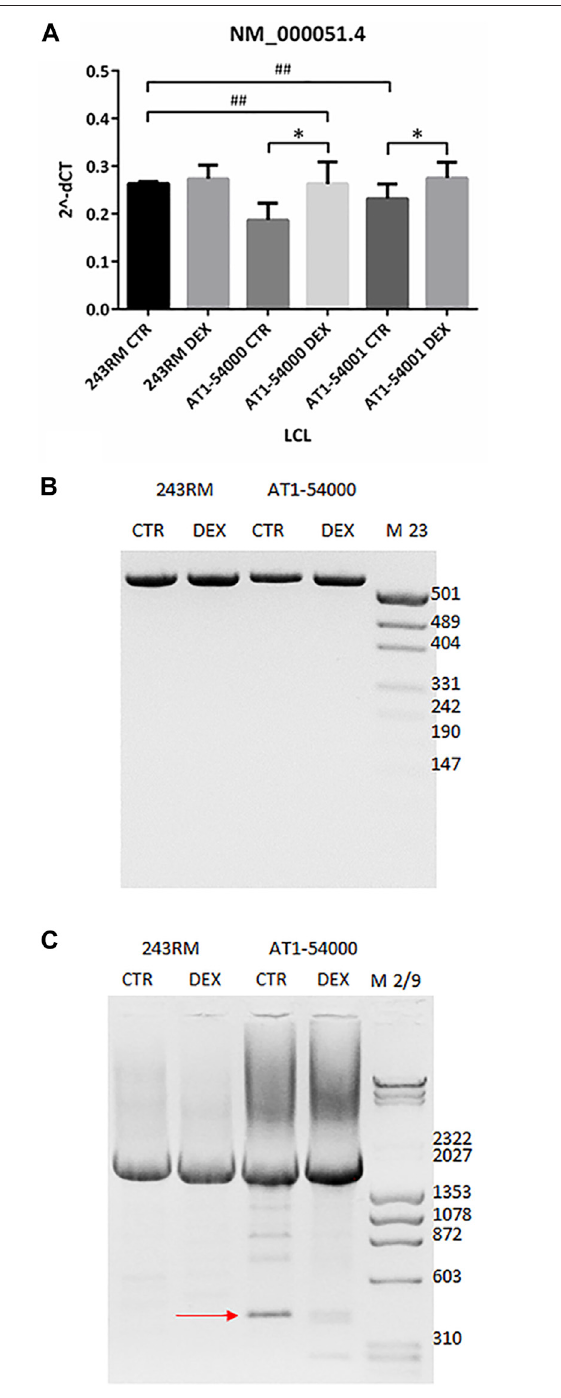
FIGURE 4 | mRNA quanti fi cation in LCL extracts. (A) The native transcript NM_000,051.4 has been quanti fi ed by Real-Time PCR on the two mutated LCLs and on a WT cell line used as control. Values are means and SEM of four independent experiments; statistics has been performed by comparing theWTCTRsamplewiththemutant CTRsamples(Mann-Whitney test, ## two-tailed p values < 0.005) or the same sample without or with DEX treatment (Wilcoxon signed rand test; *two-tailed p -values < 0.05). (B) ( Continued